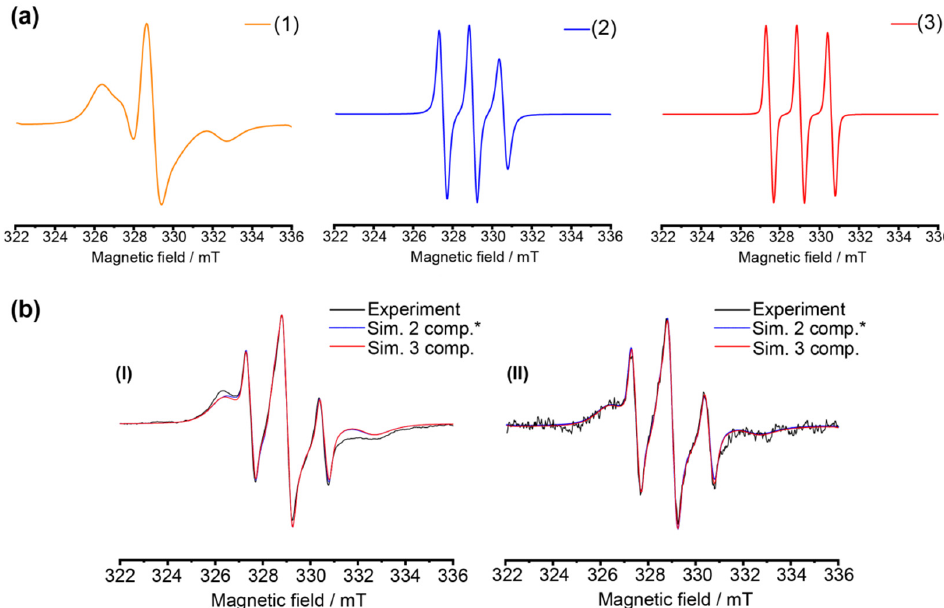
Figure 4. ( a ) Calculated EPR spectral components that were employed to simulate the experimental spectra. The spectra presented are normalized to their central signal height. Spectrum (1) represents the EPR spectral component 1 with calculated rotation correlation time τ c1 = 4.77 ns, spectrum (2)—the component 2 with τ c2 = 2.95 × 10 − 1 ns and spectrum (3)—the component 3 with τ c3 = 4.1 × 10 − 2 ns. Parameters of simulations for all three spectra: g 1 = g 2 = g 3 = [2.0091 2.0059 2.0018]; A 1 = [0.30 0.30 3.9], mT, A 2 = [0.30 0.30 4.00], mT, A 3 = [0.30 0.30 4.08], mT. ( b ) Black: experimental EPR spectra of A549 cells after their incubation with ( I ) 5.5 μ M and ( II ) 0.5 μ M sRL2 (molar ratio of spin label 1 to RL2 2 : 4) acquired at 2.16 h ( I ) and 0.96 h ( II ) from the end of the cell incubation. Solid red: simulation of the experimental spectra, which was done by applying the three EPR spectral components with their second integral weight ratios (1):(2):(3) at 0.88:0.07:0.05 ( I ) and 0.80:0.15:0.05 ( II ). Short dot blue: simulation of the experimental spectra by only two components (low mobile component 1* and highly mobile component 2*) with the following simulation parameters: g 1* = g 2* = [2.0091 2.0059 2.0018]; A 1* = [0.30 0.30 3.9], mT, A 2* = [0.30 0.30 4.05], mT; ( I ) τ c1* = 4.52 ns, τ c2* = 1.35 × 10 − 1 ns; (II) τ c1* = 4.53 ns, τ c2* = 2.65 × 10 − 1 ns; second integral weight ratios: (1*):(2*) = 0.89:0.11 (I) and (1*):(2*) = 0.85:0.15 (II).